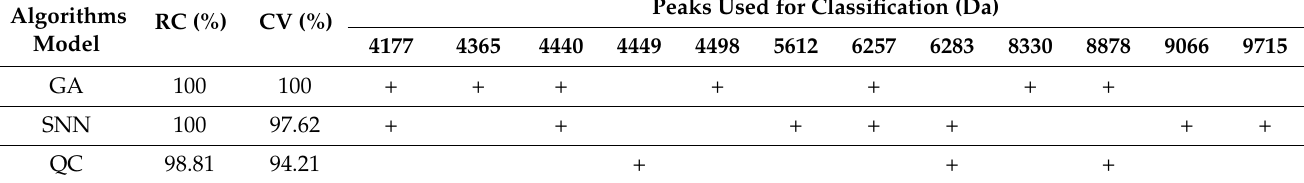
Table 1. Performances and list of peaks of the different algorithms tested. GA Genetic Algorithm; SNN Supervised Neural Network; QC Quick Classifier; RC Recognition Capability; CV Cross Validation; Da Dalton; + peak involved in classifying algorithm model